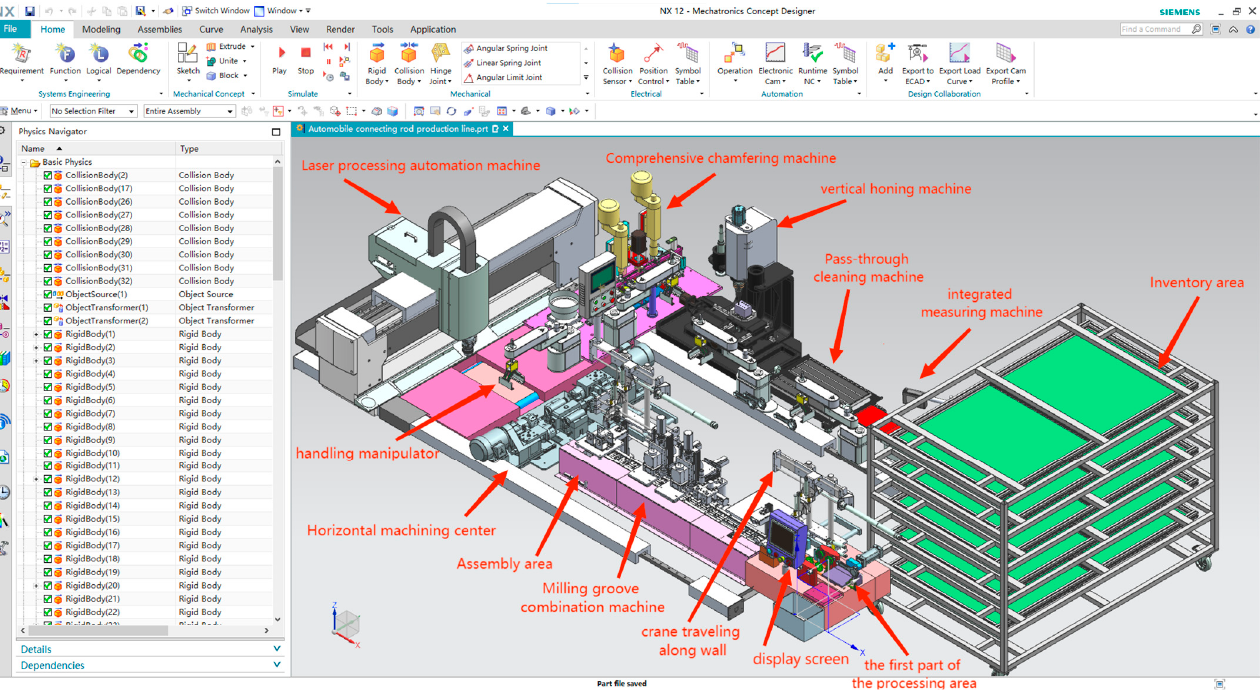
Figure 4. The automobile connecting rod production line model.